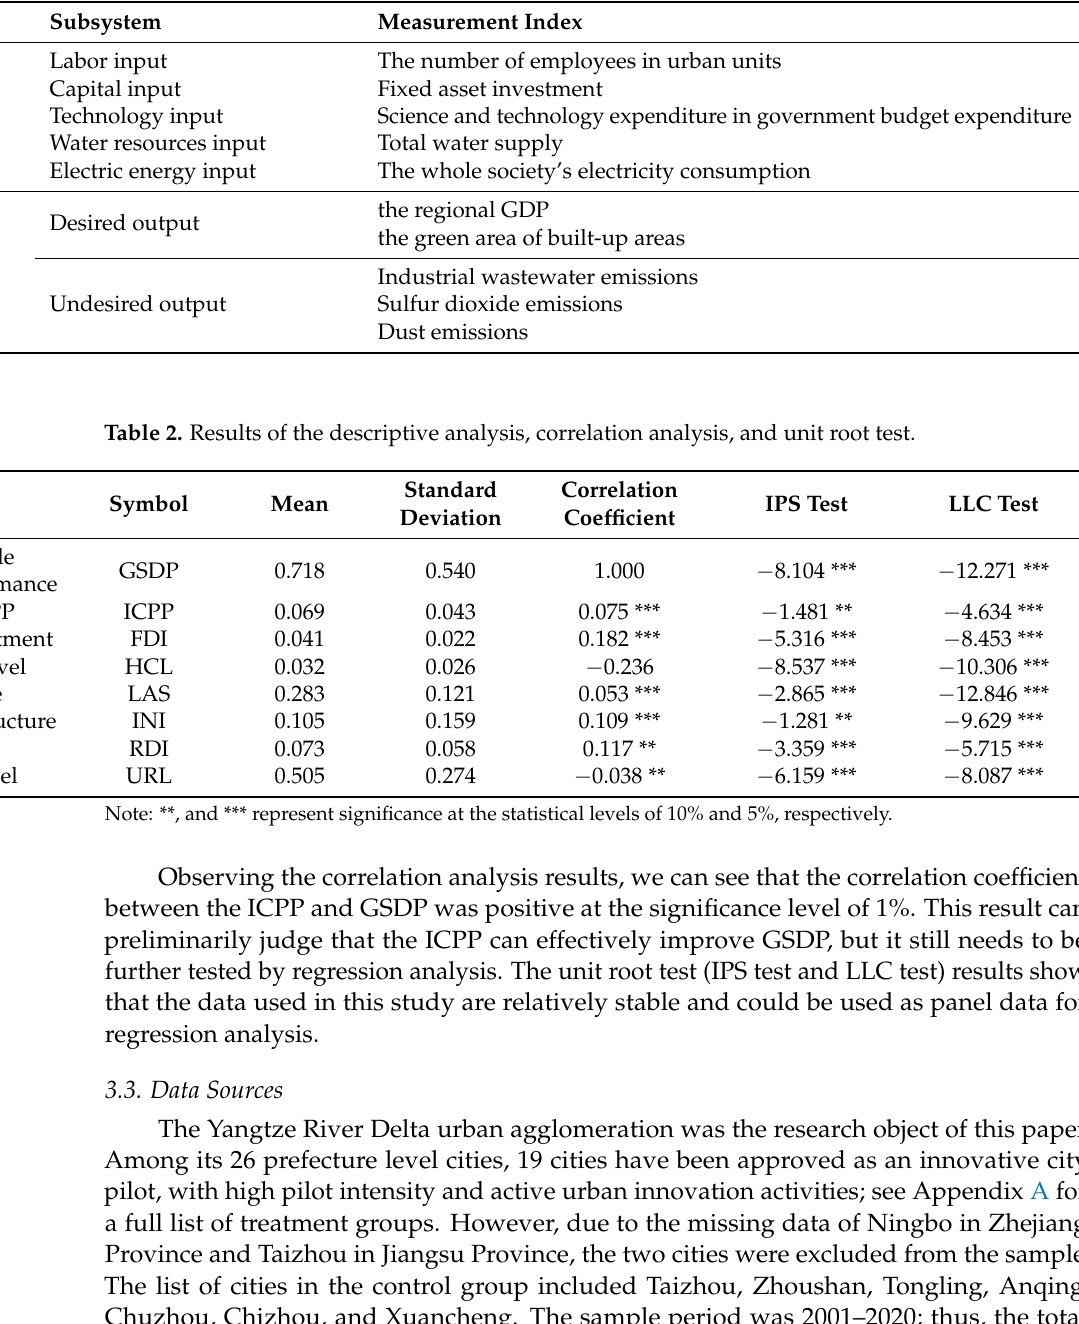
Table 1. The evaluation index system of GSDP.